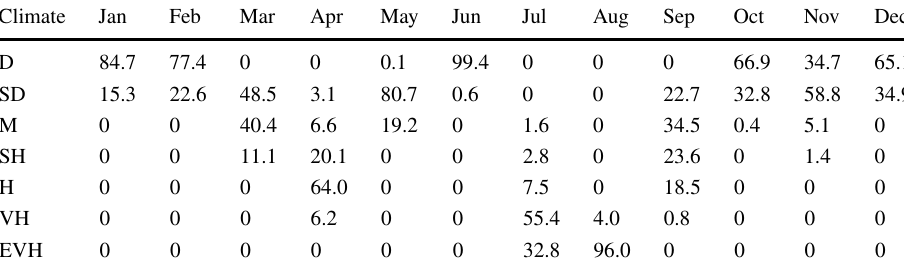
Table 7 Percentage of Raya valley within each climate category according to the monthly DeMartonne aridity index